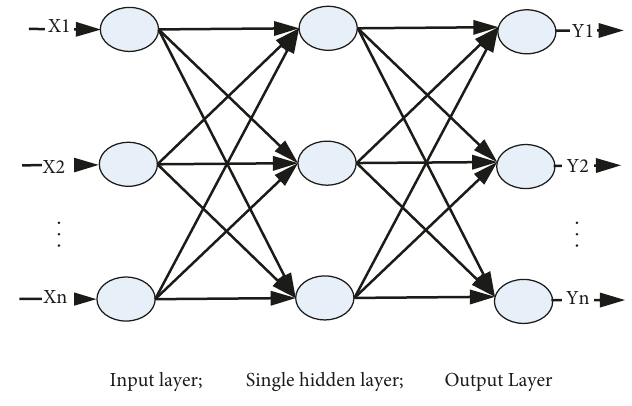
Figure 3: Structure of neural network.